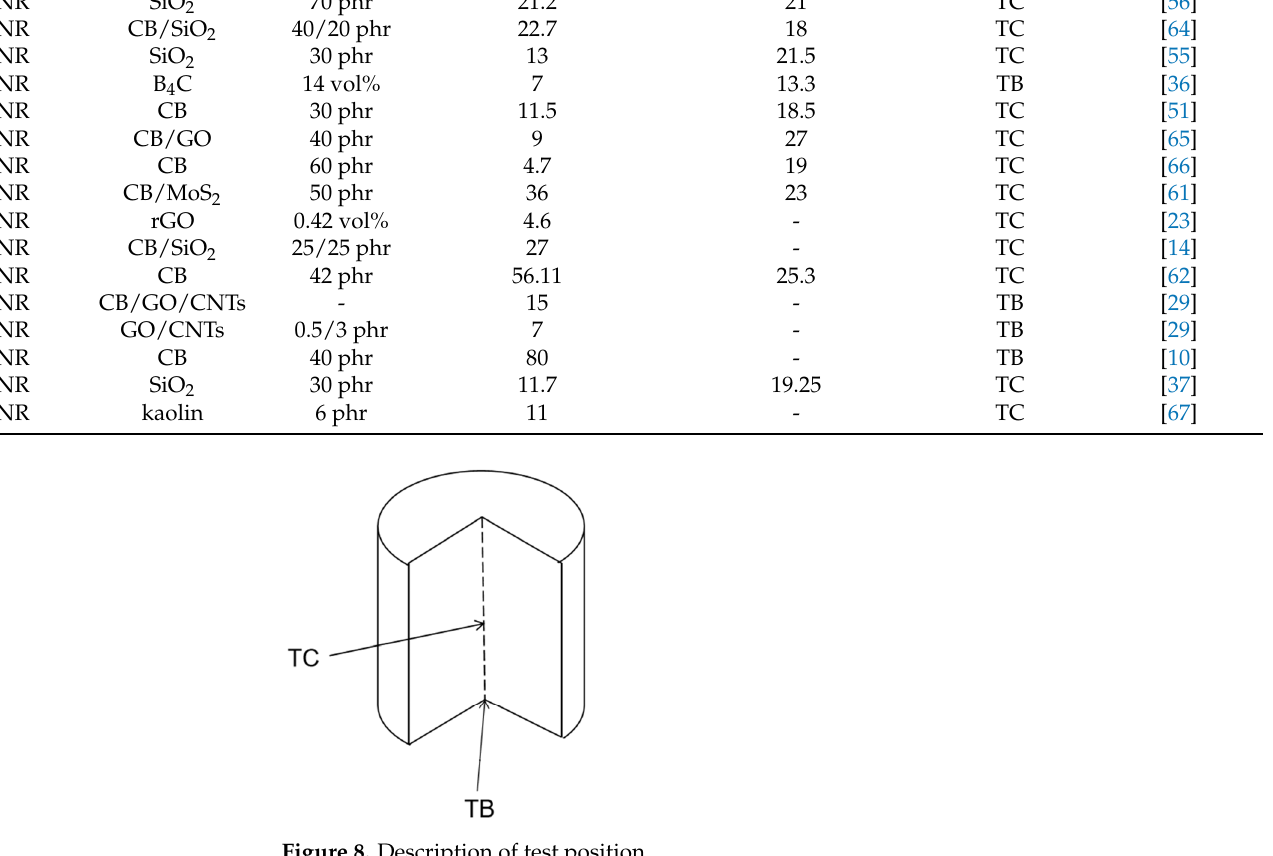
Figure 8. Description of test position.